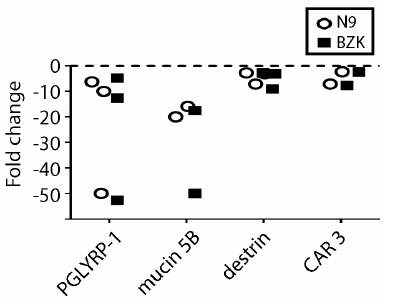
Figure 2. LC MS/MS proteomic analysis of mouse proteins in vaginal brush samples that are down-regulated in response to treatment with N9 (open, black circles) or BZK (closed squares). Shown are proteins that were decreased relative to vehicle controls. The following proteins are shown: peptidoglycan recognition protein 1 (PGLYRP-1), mucin 5 subtype B (mucin 5B), destrin, and carbonyl reductase 3 (CAR3). Each data point represents the average of three replicates per individual experimental study. Only proteins shown to change in a minimum of two studies are represented.